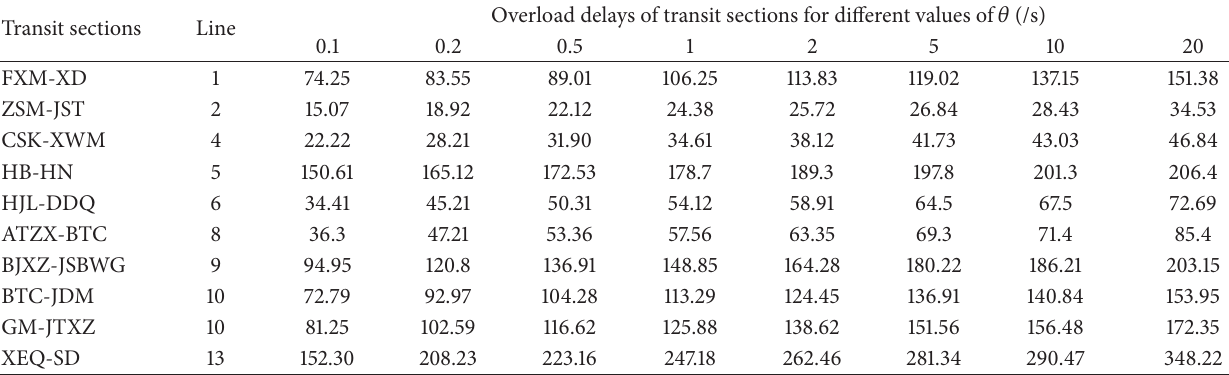
Table 4: Overload delays of transit sections for different values of the parameter 𝜃